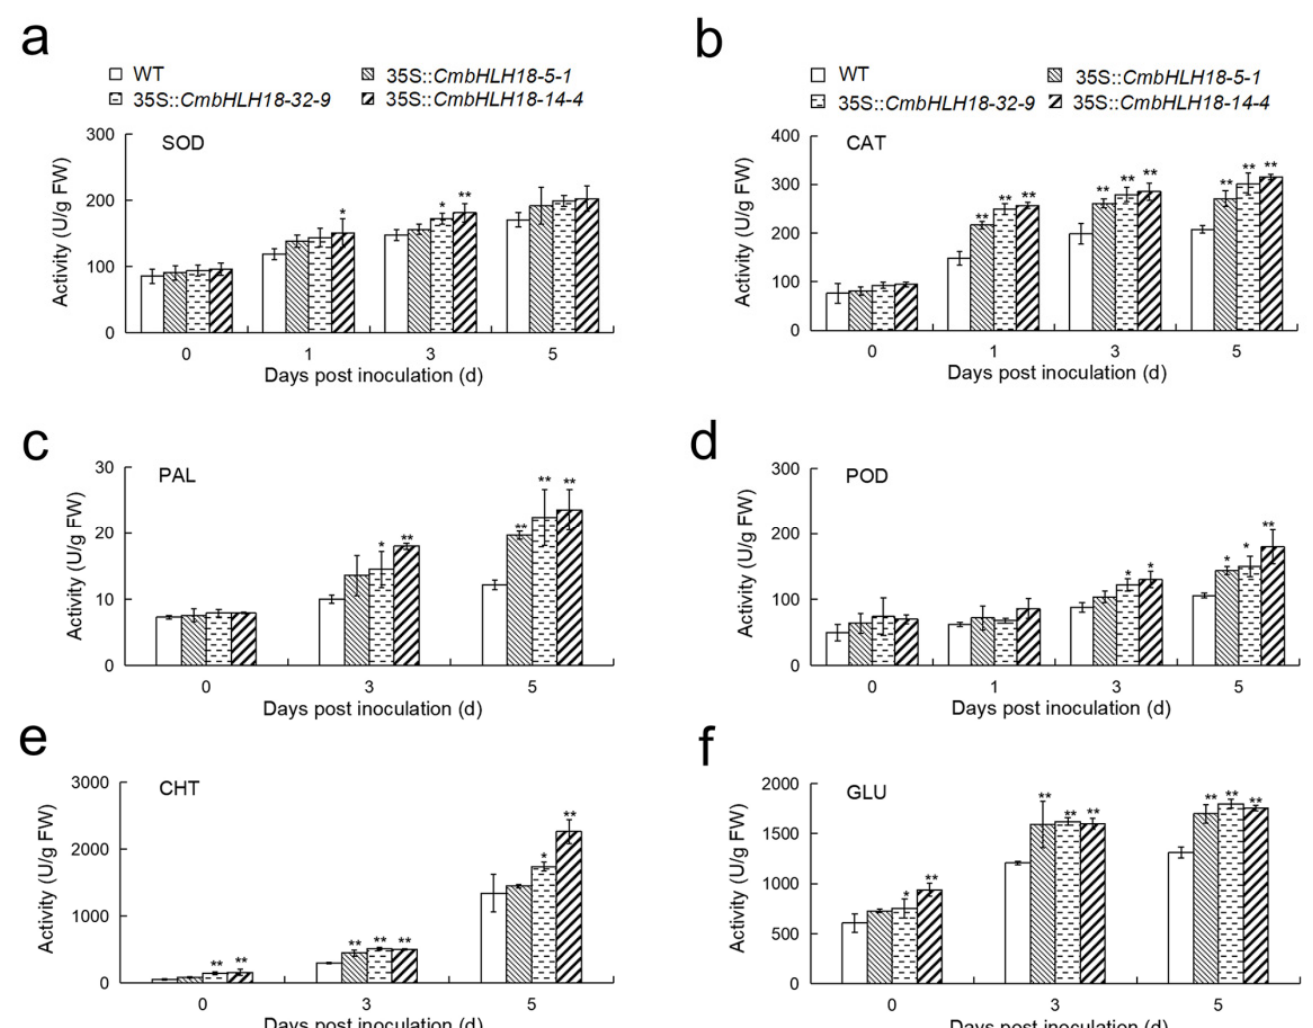
Figure 8. Effect of CmbHLH18 on the activities of antioxidant and defense enzymes in Arabidopsis after inoculation with A. brassicicola . ( a , b ) Activities of antioxidant enzymes; ( c – f ) Activities of defense enzymes. Asterisks represent statistically significant differences between different lines by t -test ( n = 3; *, p < 0.05; **, p < 0.01).